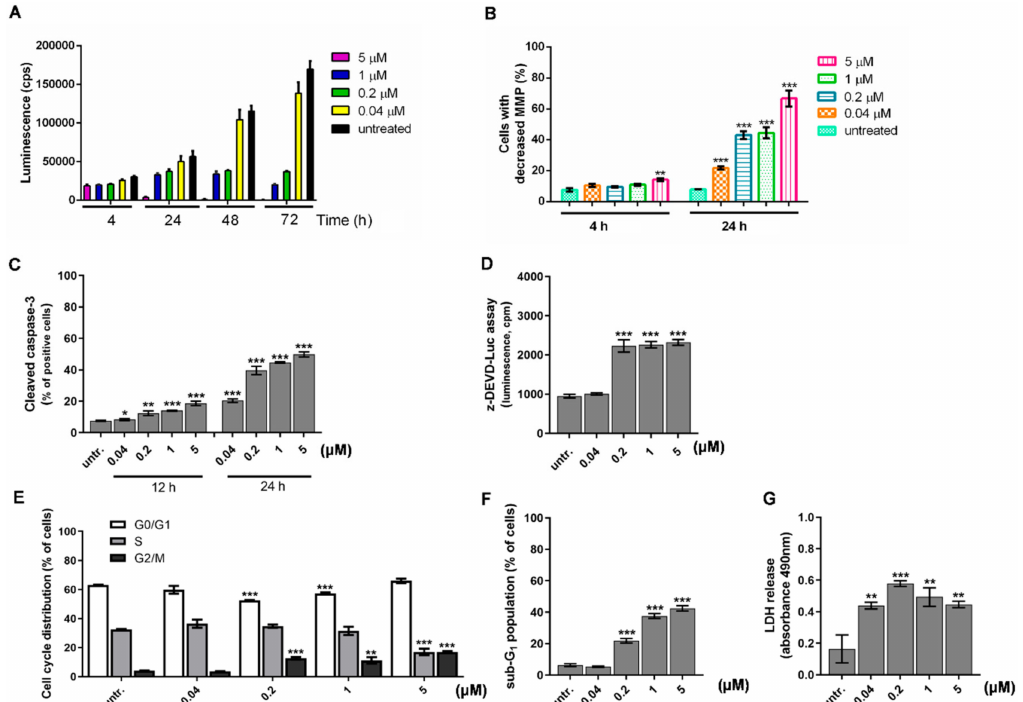
Figure 5. Di ff erentiation of promyelocytic leukemia cells is followed by apoptotic cell death. Di ff erentiation of HL-60 cells was accompanied by cell death detected by RealTime-Glo TM MT Cell Viability Assay ( A ). The depolarization of the mitochondrial membrane potential (MMP) ( B ), activation of caspase-3 ( C ), and the cleavage of Z-DEVD-aLuc ( D ) were observed after 24 h. Cell cycle was arrested in G2 / M detected after 72 h incubation ( E ). Finally, as a proof of massive cell death, we showed both the appearance of the hypodiploid apoptotic cells in the sub-G1 population ( F ) and the leakage of the lactate-dehydrogenase (LDH) into the supernatant ( G ) after 72 h incubation. Data are shown as arithmetic mean values ± standard deviation from triplicate experiments. Statistical significance was calculated in relation to untreated cells and set to * p < 0.05, ** p < 0.01, *** p <